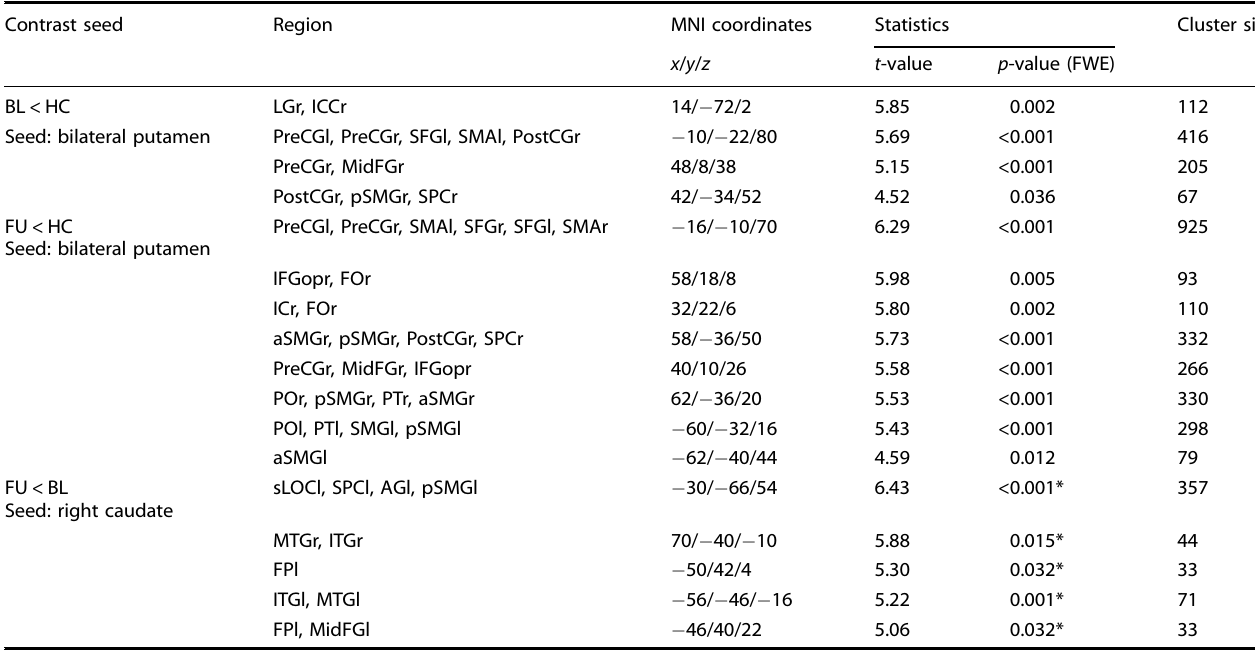
Statistical details of rs-fMRI analyses by contrast and seed volumes. Analyses were conducted in CONN as seed-based correlations with bilateral putamina or right caudate nucleus from FDOPA PET comparison (FU< HC; FU<BL) as seeds and compared by unpaired/paired t -tests. AGI angular gyrus left, ICCr intracalcarine cortex right; ICr right Insula, IFGopr inferior frontal gyrus pars opercularis right, ITGr inferior temporal gyrus right (temporo-occipital); FOr frontal operculum cortex right, FPl frontal pole left, LGr lingual gyrus right, MidFGl middle frontal gyrus left, MidFGr middle frontal gyrus right, MTGl mid temporal gyrus left (temporo-occipital), MTGr mid temporal gyrus right (temporo-occipital), POl parietal operculum cortex left, POr parietal operculum cortex right, PostCGl postcentral gyrus left, PostCGr postcentral gyrus right, PreCGr precentral gyrus right, PreCGl precentral gyrus left, PTl Planum temporale left, PTr planum temporale right, SFGI superior frontal gyrus left, SFGr superior frontal gyrus right, sLOCl superior lateral occipital cortex, SMAl supplementary motor area left, SMAr supplementary motor area right, aSMGl supramarginal gyrus left anterior, aSMGr supramarginal gyrus right anterior, pSMGl supramarginal gyrus left posterior, pSMGr supramarginal gyrus right posterior, SPCl superior parietal cortex left, SPCr superior parietal cortex right, STGl superior temporal gyrus left, STGr superior temporal gyrus right. *thresholded at cluster-level p FDR